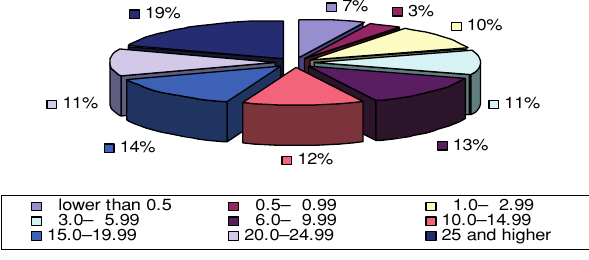
Source: Own figure based on CSO data Figure3: Times of the establishment of apple orchards inWestTransdanubia F